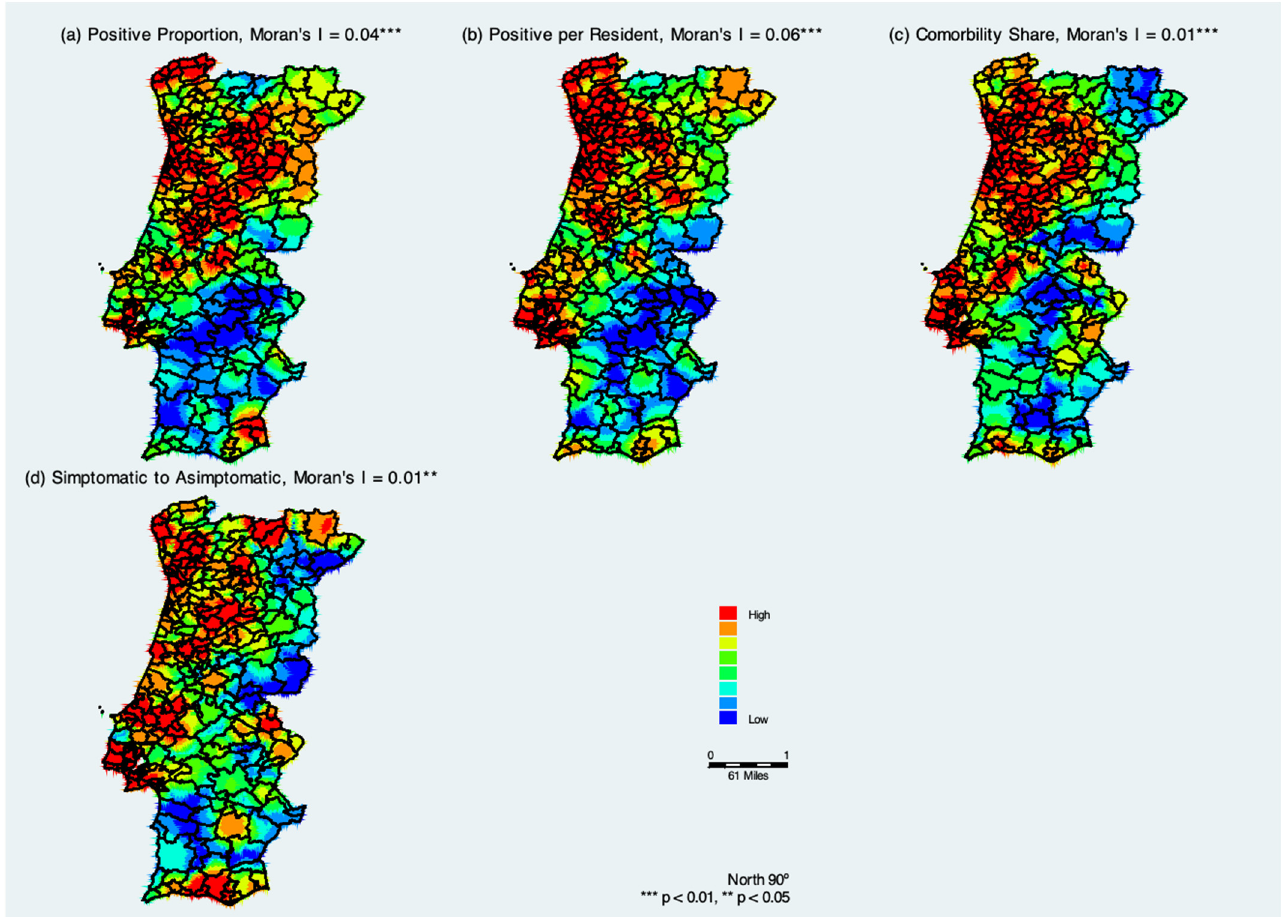
Figure 2. Kernel density estimation of COVID-19 infection 4 measures in residential care homes Portugal based on cumulative positive cases from March through December 2020. Subfigure ( a ) Elderly positive cases as a proportion of total positive cases; ( b ) Positive cases per elderly living in residential health care; ( c ) Comoobility share, i.e., number of positive cases with comorbidities divided by the total number of positive cases; ( d ) Symptomatic to asymptomatic ratio, i.e., number of symptomatic positive cases divided by the asymptomatic number of cases.